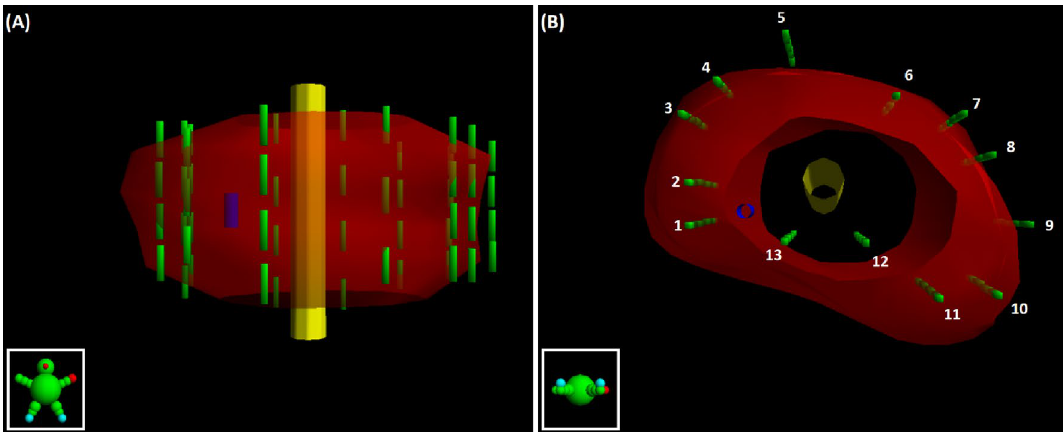
Figure 4. ( a ) Coronal view of structures/sources in VariSeed TPS: sensor (blue cylinder), prostate (red), urethra (yellow), and I-125 seeds (green). ( b ) Transverse view of structures / sources with needle numbers also identified.